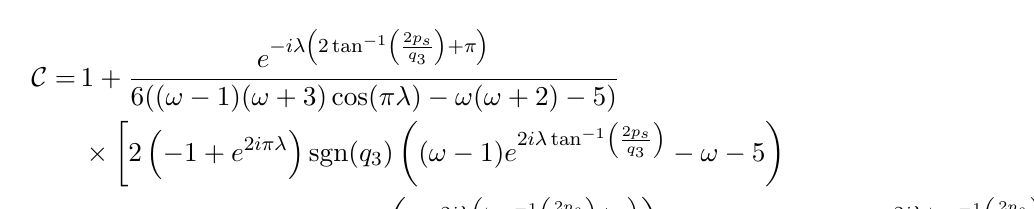
Figure 8. Diagrams contributing to